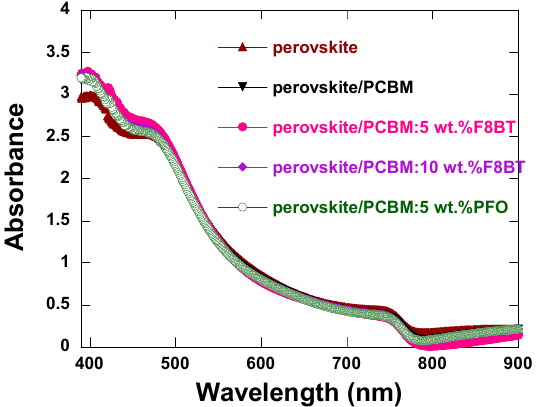
Figure 4. Ultraviolet–visible absorption spectra of perovskite, perovskite/PCBM, perovskite/PCBM: x wt % F8BT (x = 5, 10) and perovskite/PCBM: 5 wt % PFO.